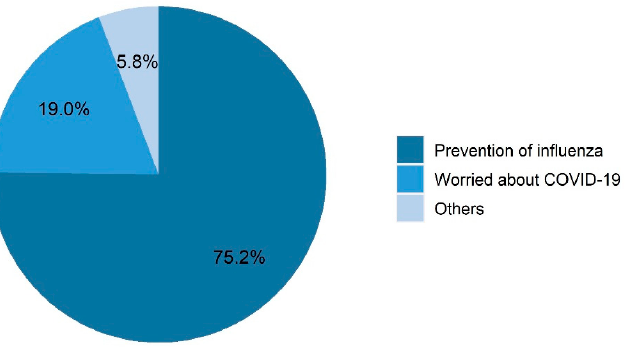
Figure 2. Reasons for taking the influenza vaccination during the 2020–2021 flu season in the cross-sectional survey ( n = 415).